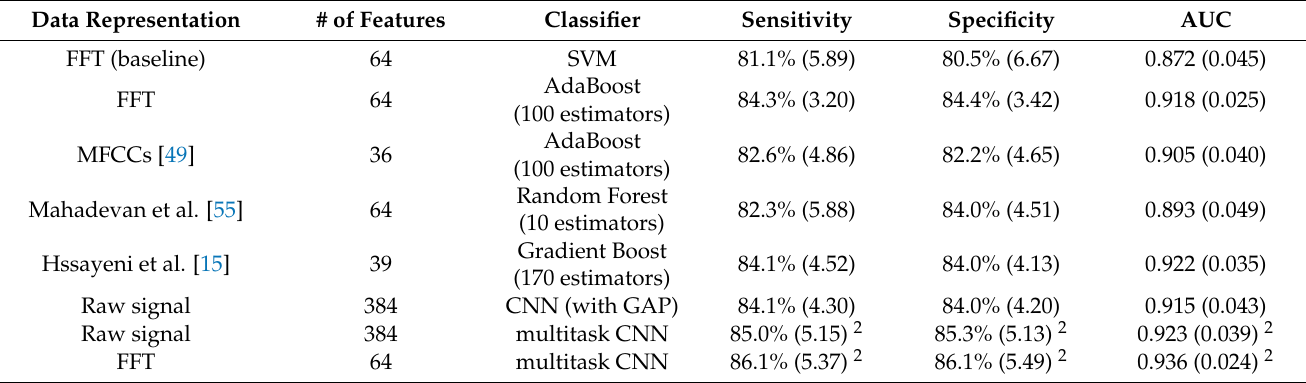
Table 5. Results of the LOSO evaluation for different classifiers with data of patients with tremor. Data